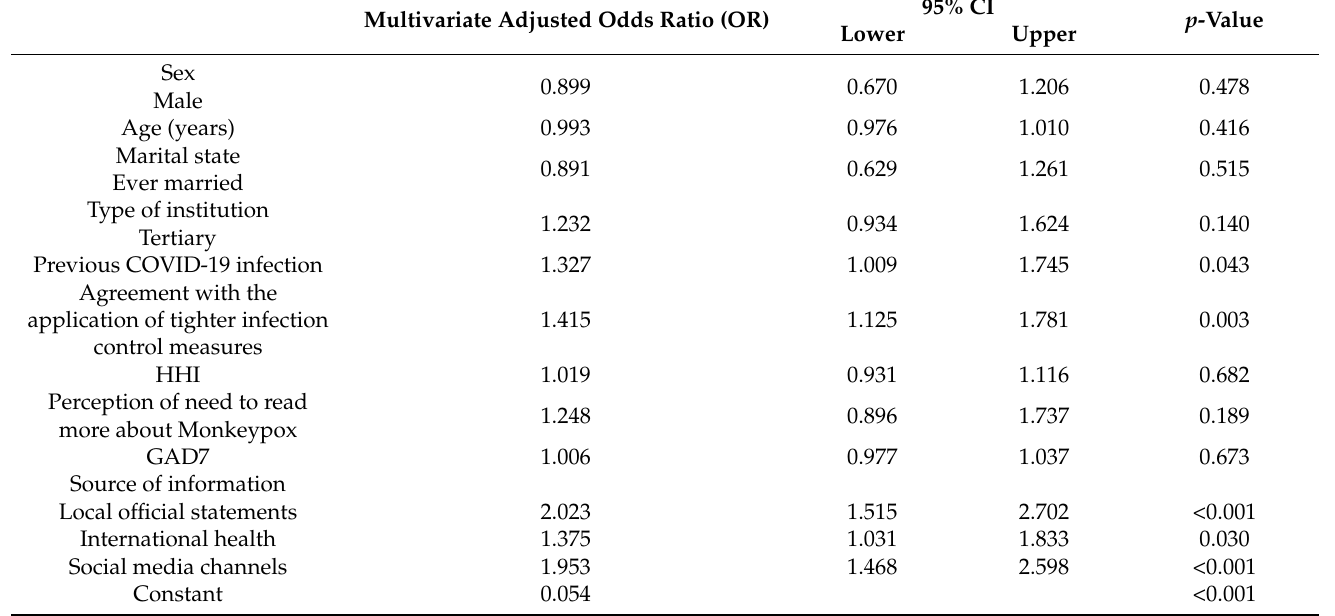
Table 5. Multivariate binary logistic regression analysis of the HCW’s odds of supporting vaccinations against Monkeypox disease. Multivariate Adjusted Odds Ratio